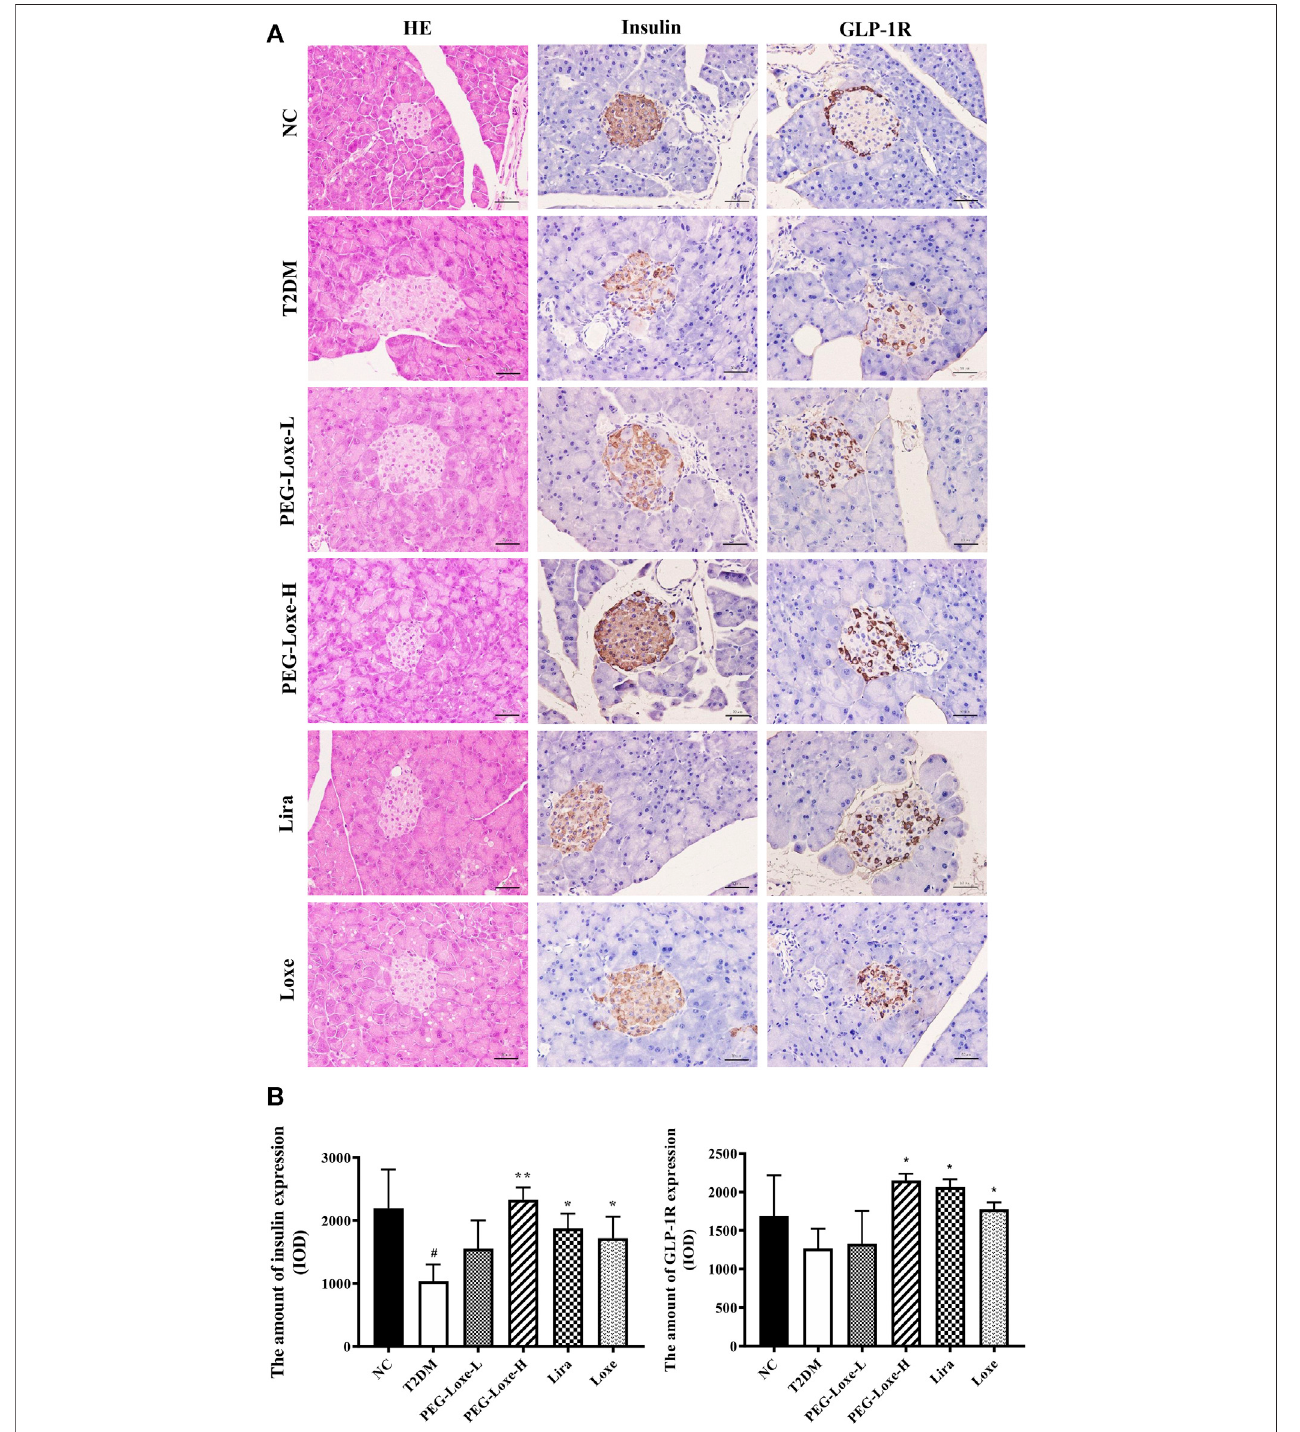
FIGURE6| Polyethyleneglycolloxenatide(PEG-Loxe)preventsinjurytopancreaticisletsandpromotesinsulinsecretionandGLP-1Rproductionin db/db mice (A) Histological examination ofpancreaticislet slices withhematoxylin and eosin(H&E) staining(400 × )and representative images ofislet insulinand glucagon-likepeptide-1 receptor (GLP-1R) staining by the immunohistochemistry test (400 × ) (B) Quantitative immunohistochemical analysis of insulin and GLP-1R levels in islets. Data are presented as the mean ± SD; n (cid:2) 3; # p < 0.05 compared to the normal control group; * p < 0.05 and ** p < 0.01 compared to the T2DM group.